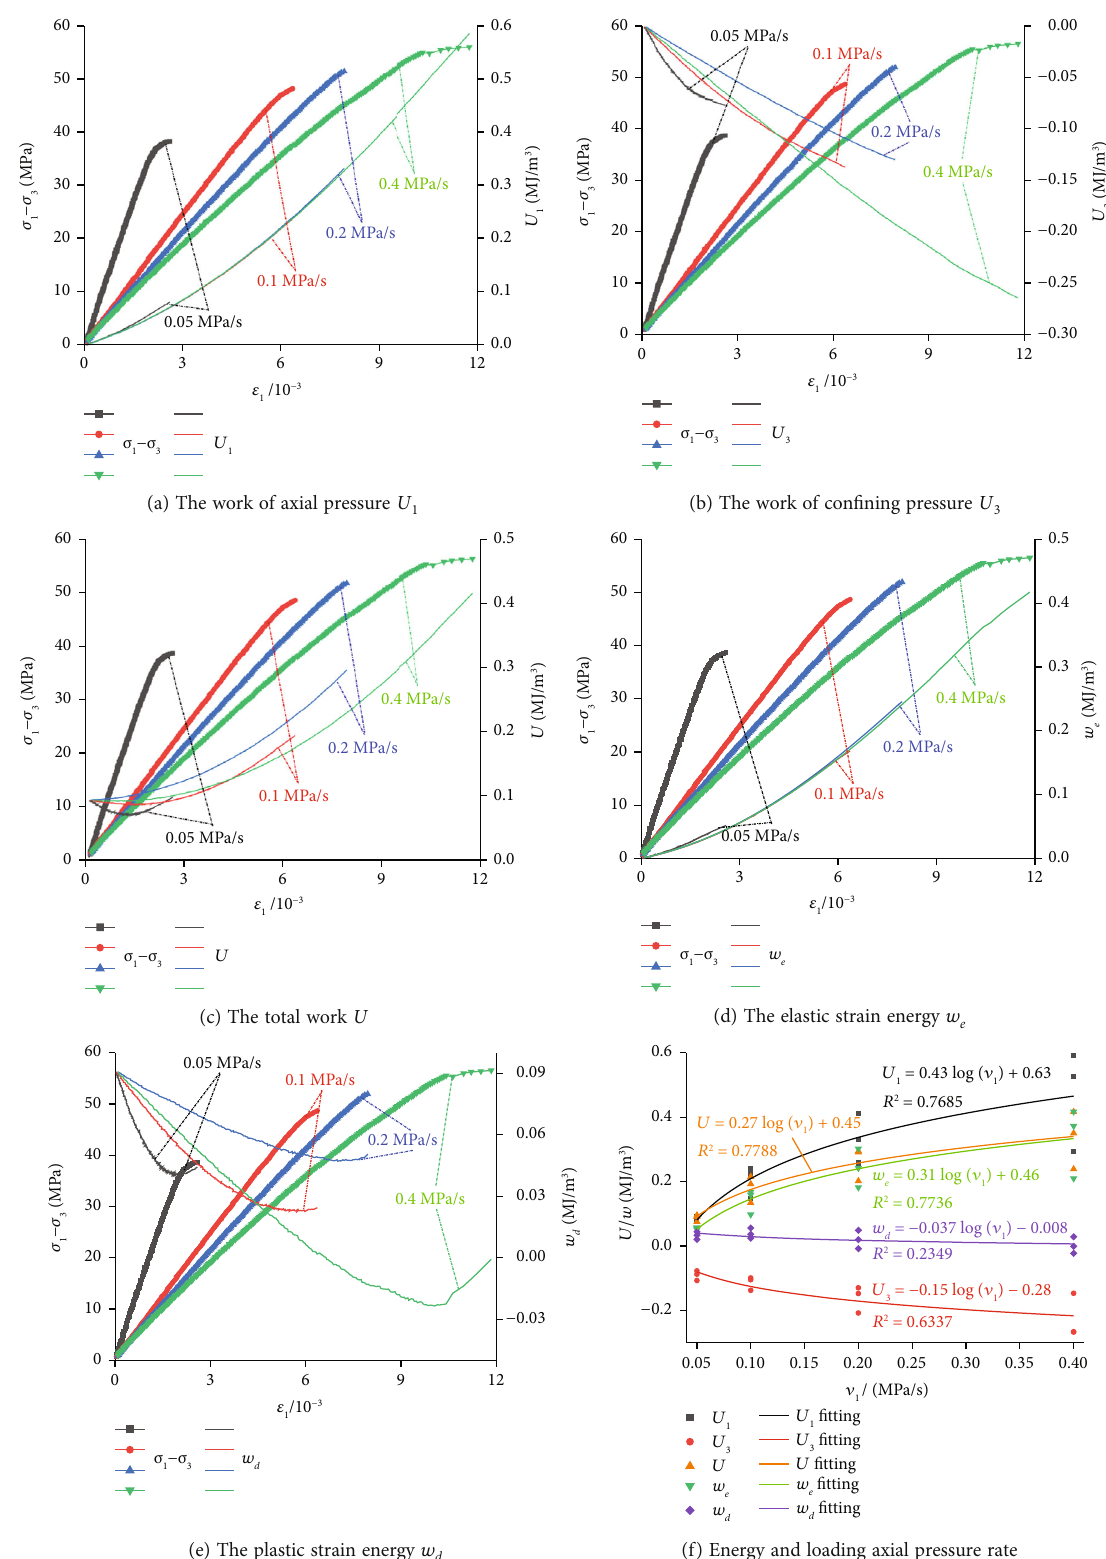
Figure 8: Energy evolution